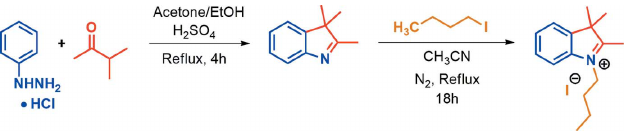
Figure 3 Synthesis scheme for the title compound.